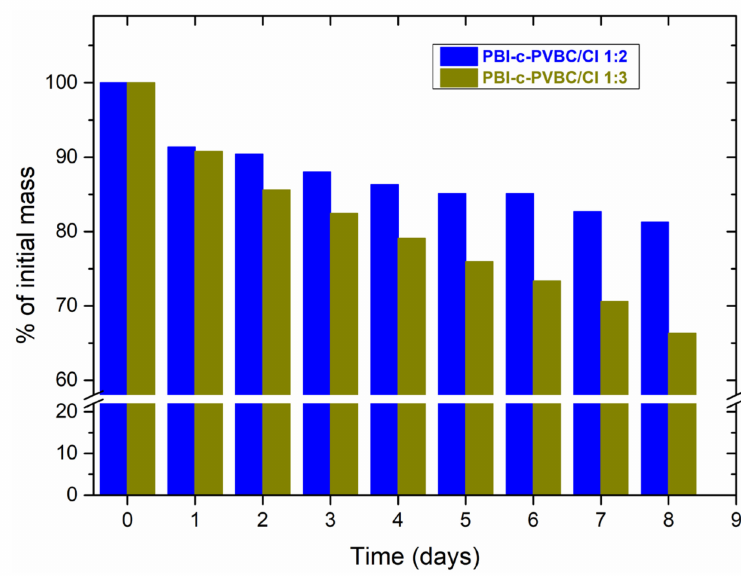
Figure8. LossofmassunderaccelerateddurabilitytestinoxidativemediaofPBI-c-PVBC / Clmembranes.